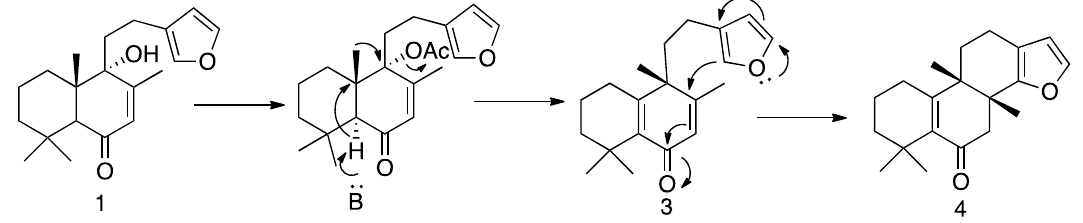
Figure 2. Representative minimum-energy conformer of compound 3. When 1 was reacted with 2 equiv. of Br 2 /DCM, the brominated compounds ( 5 ) and ( 6 ) were formed. The regiosubstitution of the furan ring was determined by an HMBC experiment. Thus, the following HMBC correlations: H-14 with C-13, C-15, and C-16; and H-12 with C-13, C-14, and C-16 located the two bromine atoms at the carbons C-15 and C-16. The third bromine was located at C-7 in compound 6 , since a singlet was observed at δ 4.37, which showed HMBC correlations with the carbonyl carbon at δ 203.3 (C-6) and with the olefinic carbons C-8 and C-9. The relative orientation was determined as β on the basis of the ROEs detected in the ROESY spectrum. The reaction of 1 with BBr 3 led to the monobrominated derivative ( 7 ), which showed similar NMR data to compound 6 , but corresponding to the furan ring. A similar chlorine derivative ( 8 ) was obtained when 1 was reacted with thionyl chloride in DCM. The treatment of 1 with NaH in THF led to derivative ( 9 ). The hydrogenation of 1 yielded the corresponding derivative ( 10 ) with the furan ring reduced to tetrahydrofuran. The orientation α of the methyl group at C-8 was established on the basis of the NOE effect between the multiplet at δ 2.34 (1H, H-8) and the singlet at δ 1.03 (3H, H-20). 2.1. Effects of Solidagenone Derivatives on Inflammatory Responses To evaluate whether these diterpenes ( 1 – 10 ) regulate the inflammatory response, we investigated the anti-inflammatory effects and underlying mechanisms of action of these derivatives in peritoneal macrophages. We first identified compounds which can inhibit the inflammatory response induced by bacterial lipopolysaccharide (LPS), a well-characterized ligand of TLR4 in murine peritoneal macrophages. For this, cells were preincubated with diterpenes for 30 min before their stimulation with LPS (200 ng/mL), and NO production was assayed. Initial testing of the